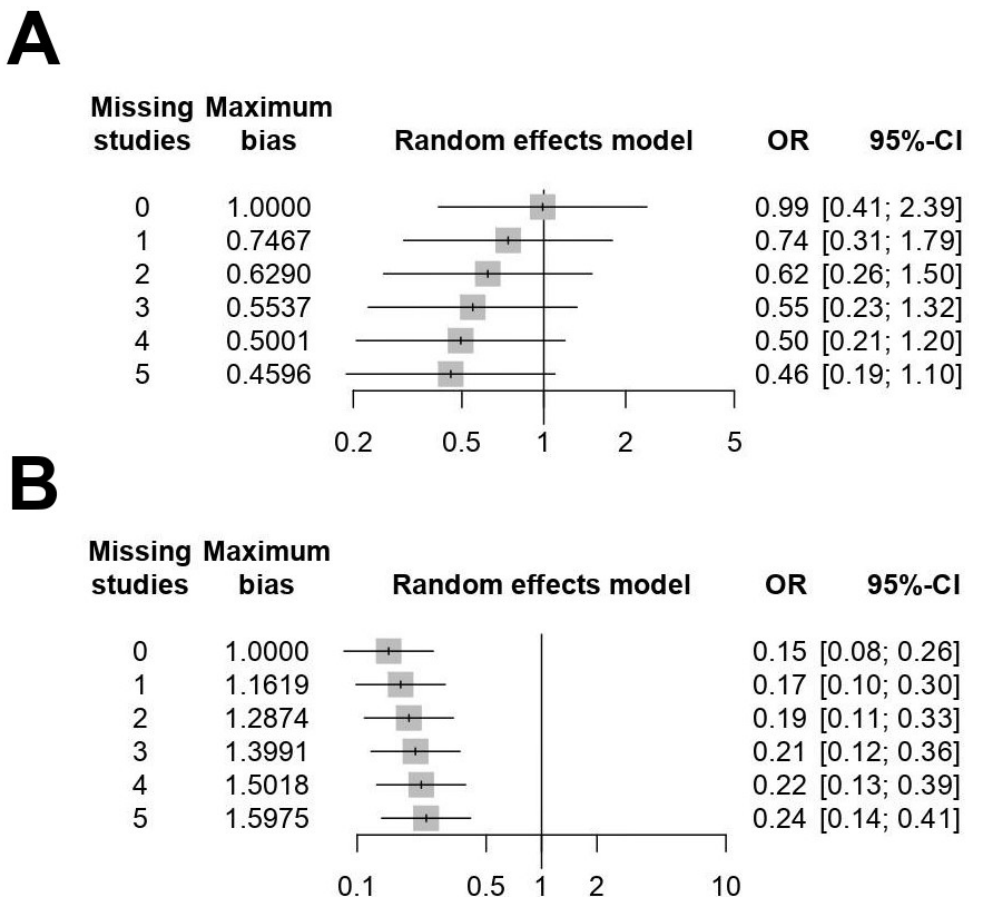
Figure 7. Sensitivity analysis for the outcome reporting bias (ORB) of 5-year overall survival (OS) ( A ) and 5-year recurrence-free survival (RFS) ( B ). The sensitivity was considered robust in the sensitivity analysis for